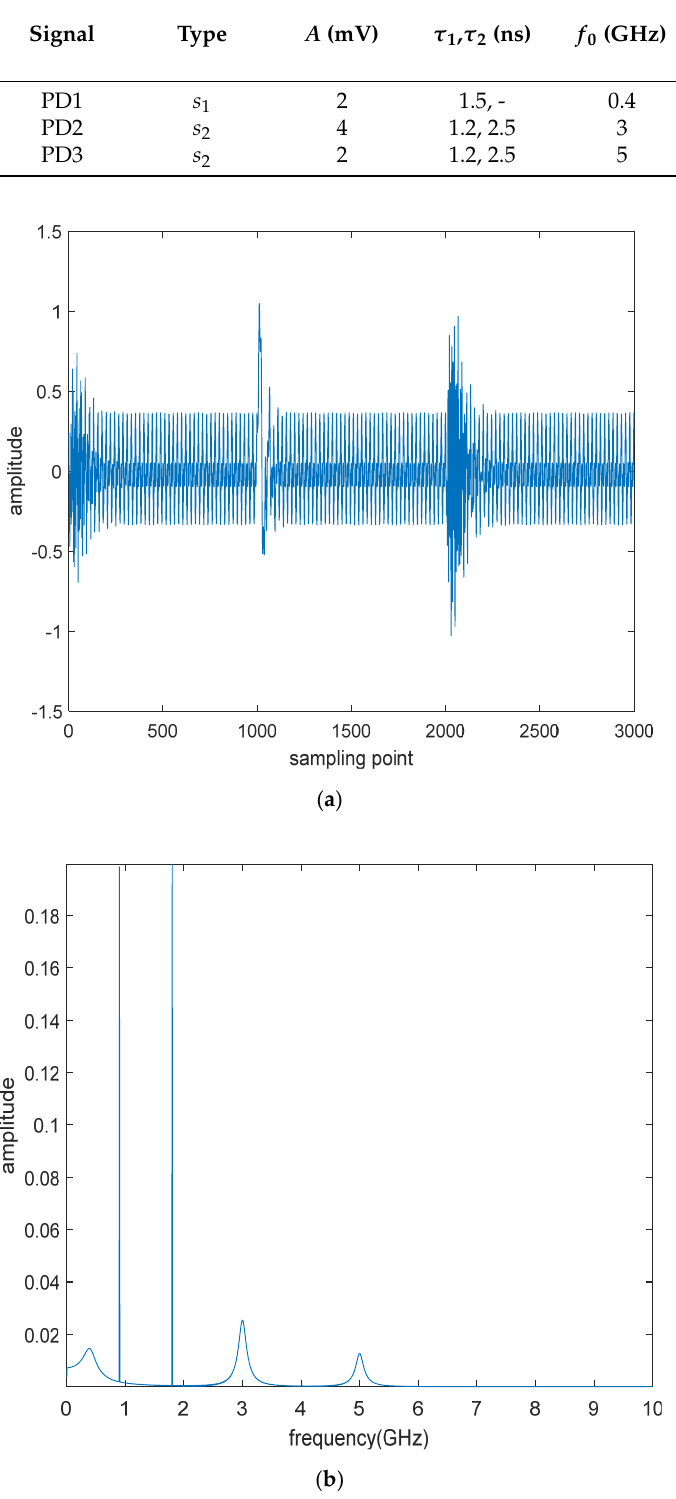
Figure 4. Noisy PD with sinusoidal noise only. ( a ) In the time domain and ( b ) in the frequency